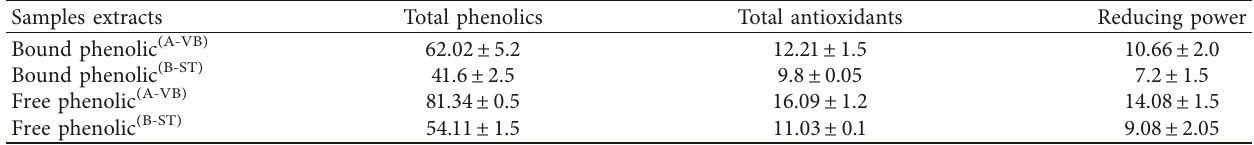
Table 1: The total antioxidants and phenolics potential in medicinal plants A-VB and B-ST.